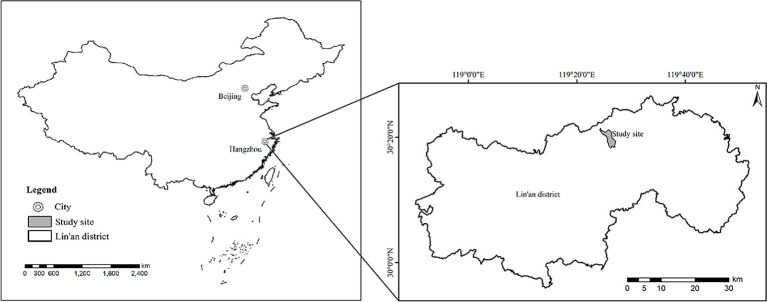
Location of the study area (Lin’an district, Hangzhou city, Zhejiang
Province, China).